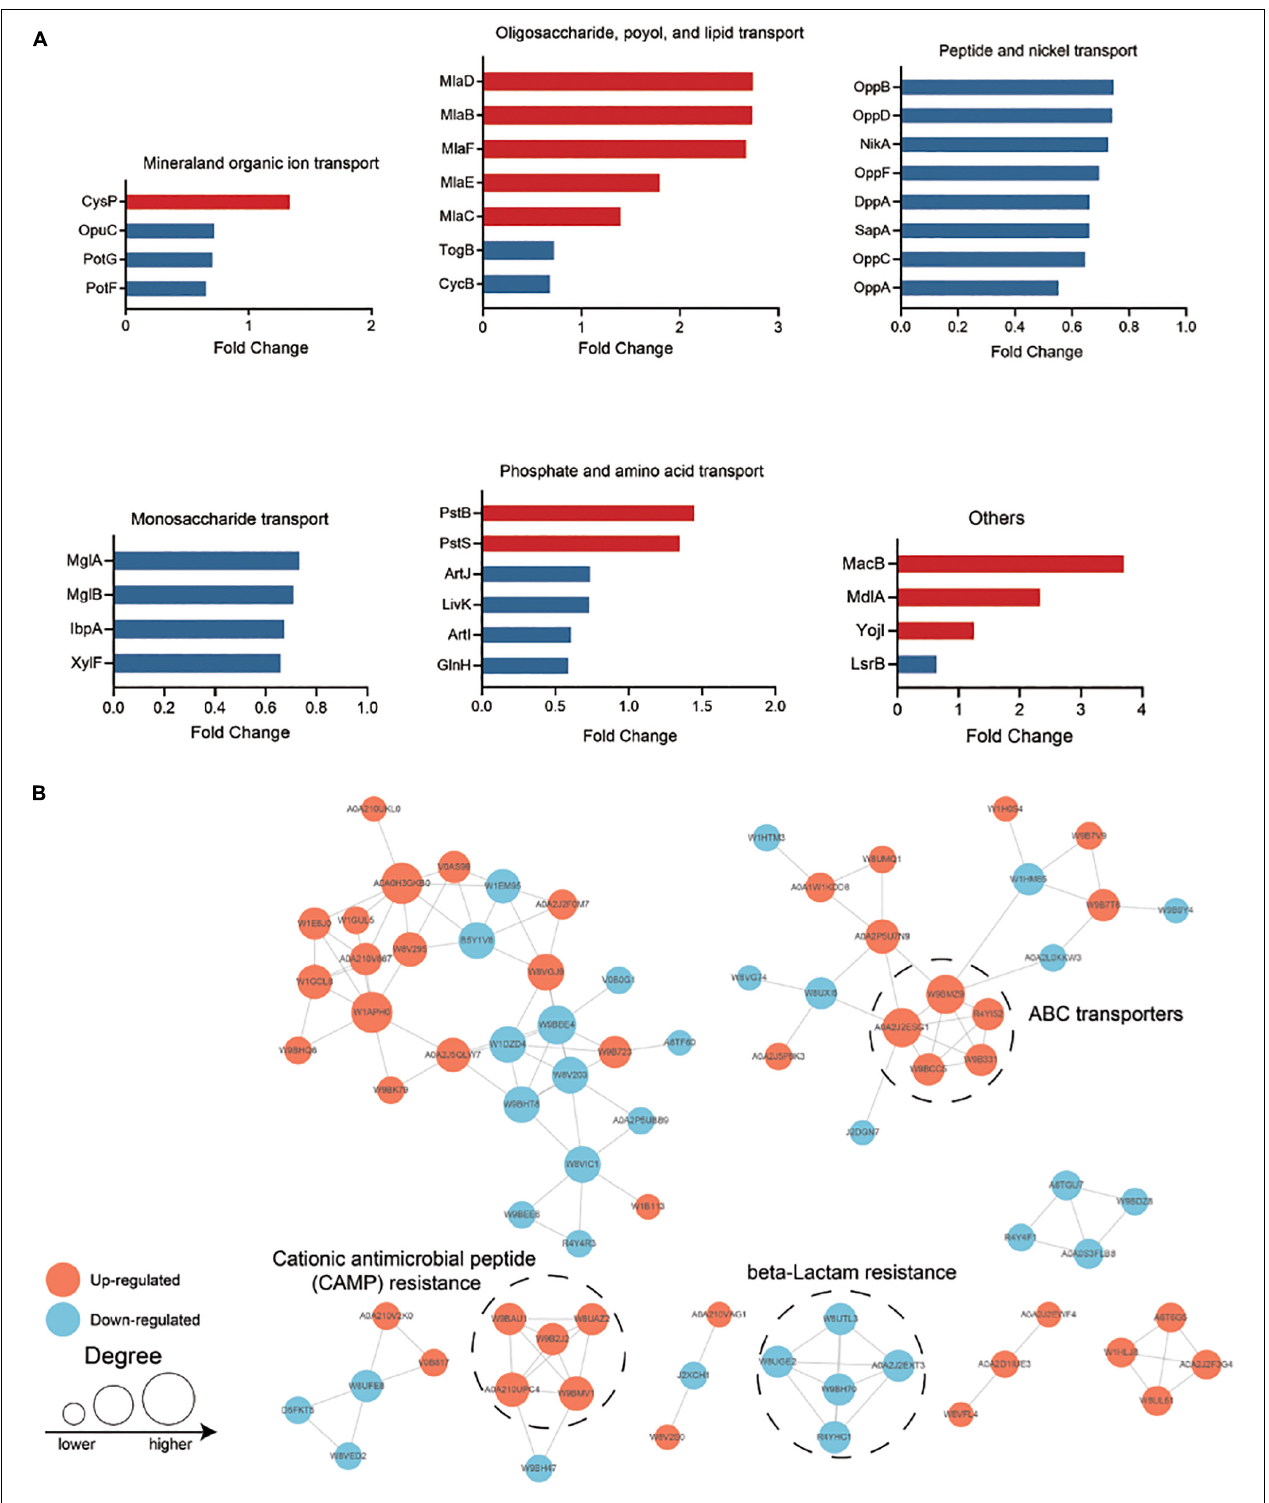
FIGURE 4 | (A) Differentially expressed ATP-binding cassette (ABC) transporters in polymyxin B (PB) resistant Klebsiella pneumoniae . (B) Protein—protein interaction (PPI) network analysis of the remained differentially expressed proteins (DEPs). The size of the node indicates the number of interacting proteins. The upregulated proteins are shown in orange and the downregulated proteins are in